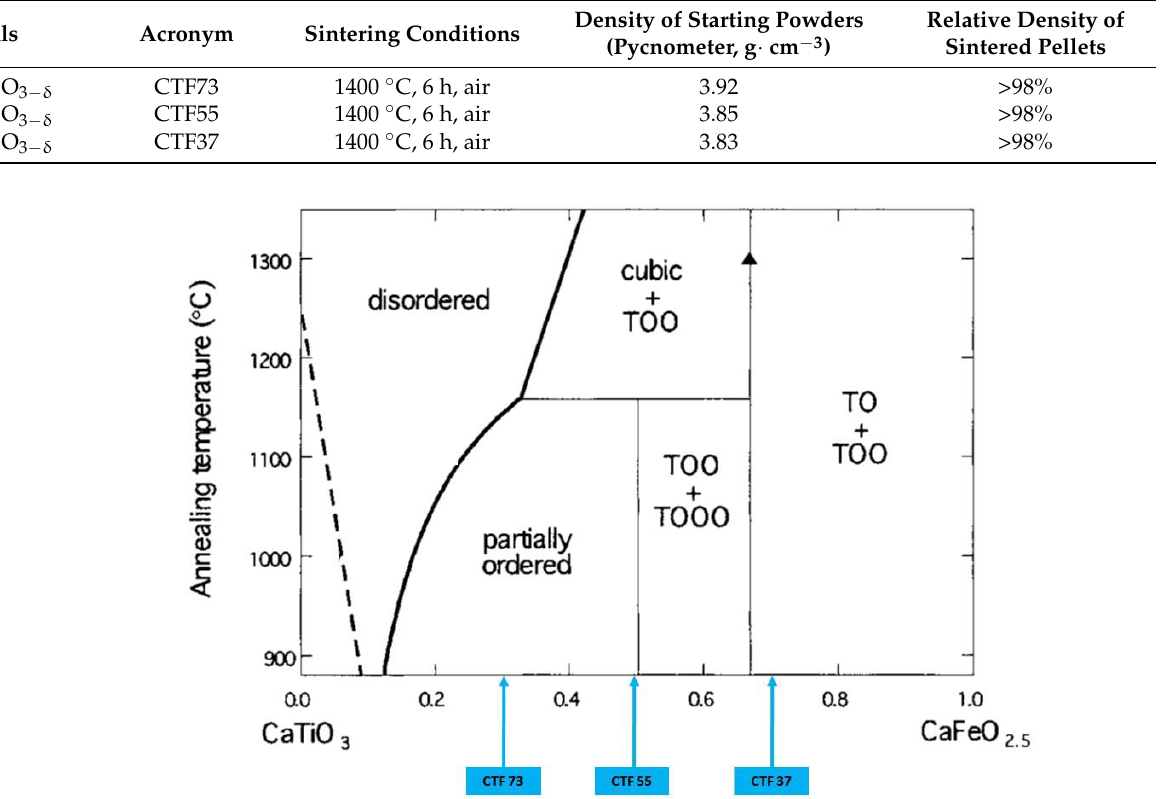
Table 1. Dense CaTi 1 − y Fe y O 3 − δ Perovskite Pellets Sintering Conditions.